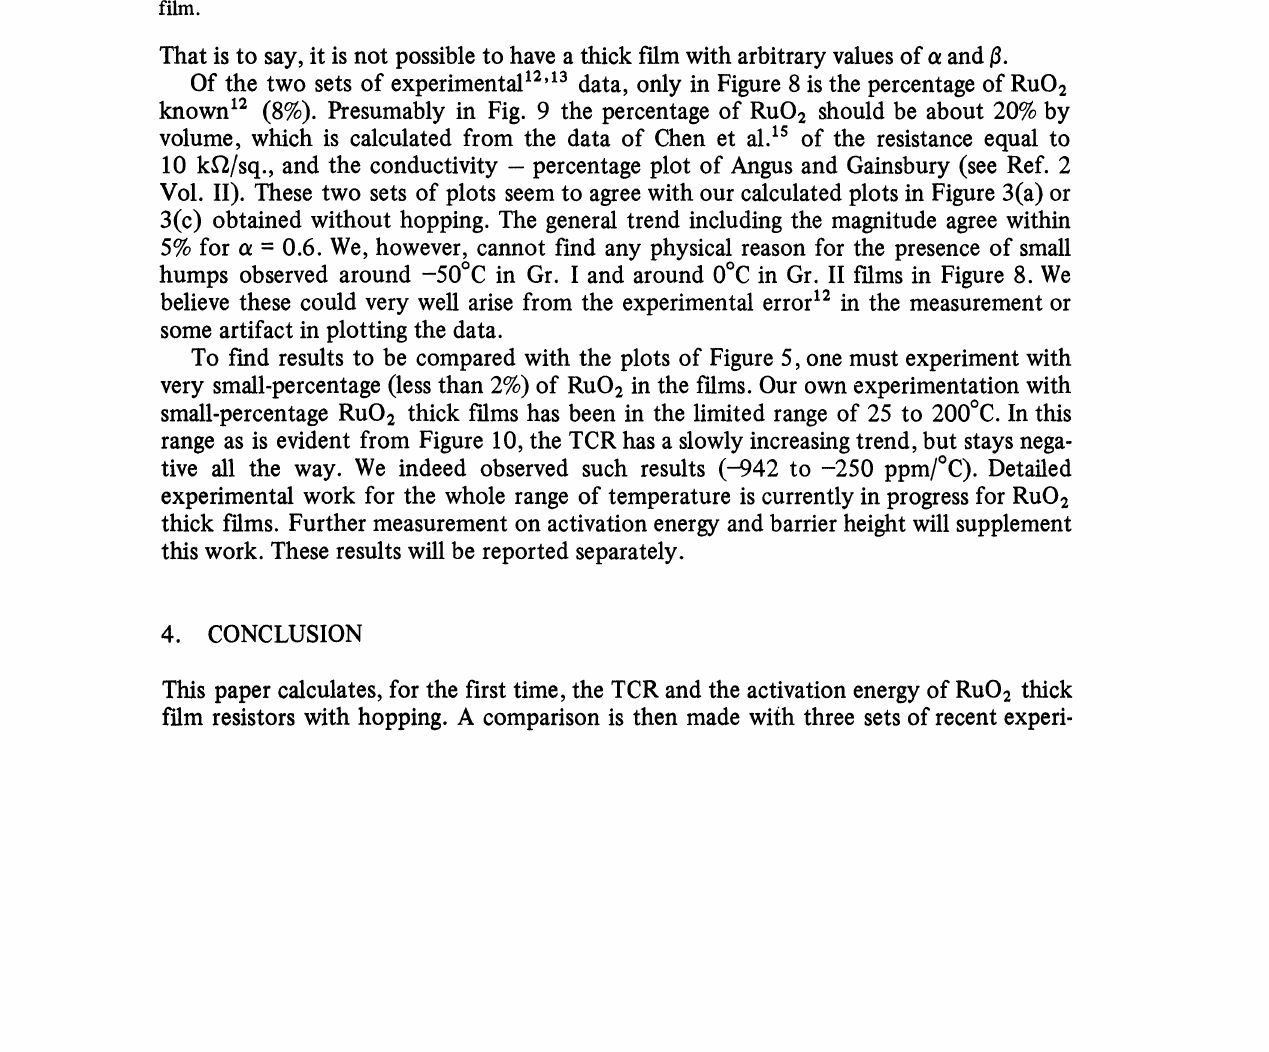
FIGURE 10 The present experimental plots of resistance and TCR for 11 # thick RuO2 films (with 2% RuO and 0.3 # particle size) in the 20-200 C range. Note the high resistance and large